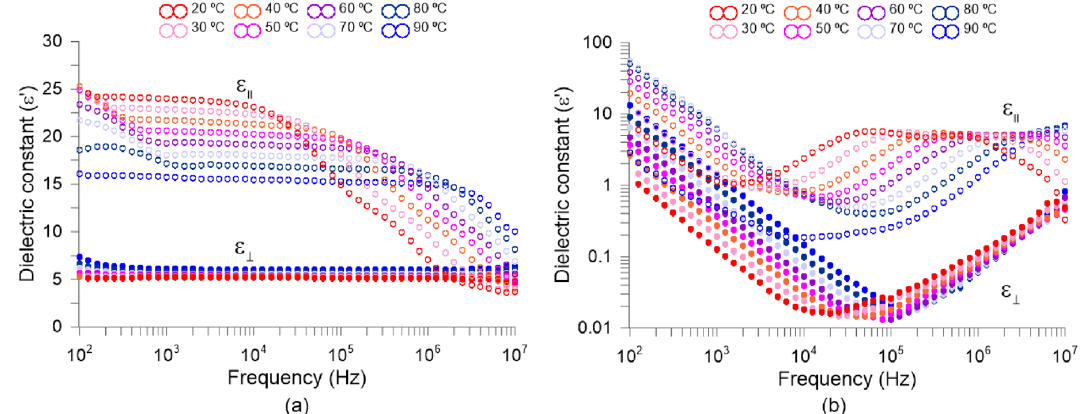
Figure 5. Frequency dependence of complex relative permittivity. ( a ) Real ( ε ′ ) and ( b ) imaginary ε ′′ .